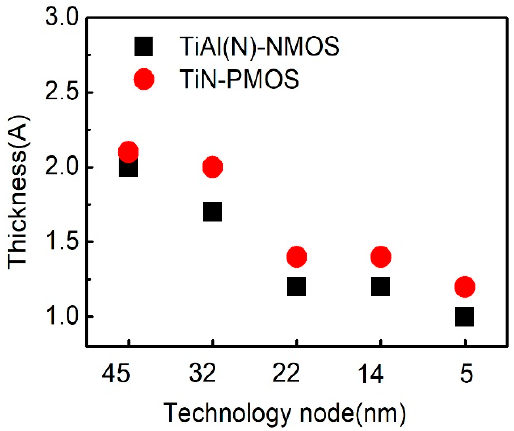
Figure 26. Work function metal thicknesses from 45 nm to 5 nm node.